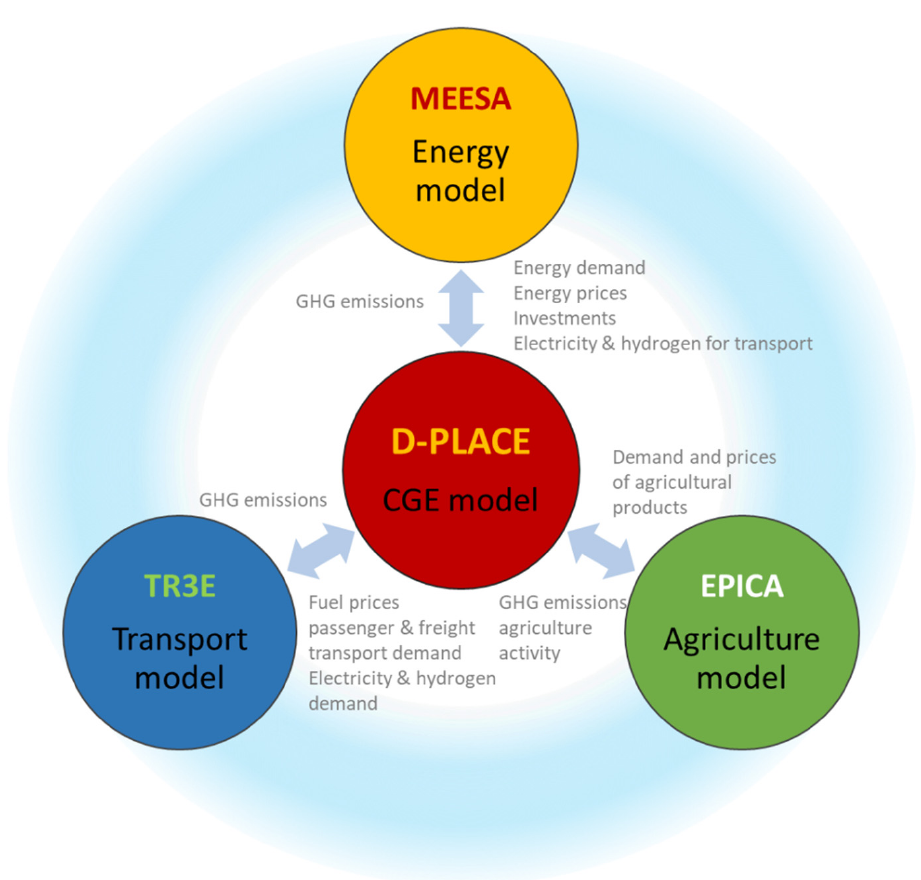
Figure 2. LIFE Climate CAKE PL project: general scheme of models and interactions. Source: own elaboration [37].